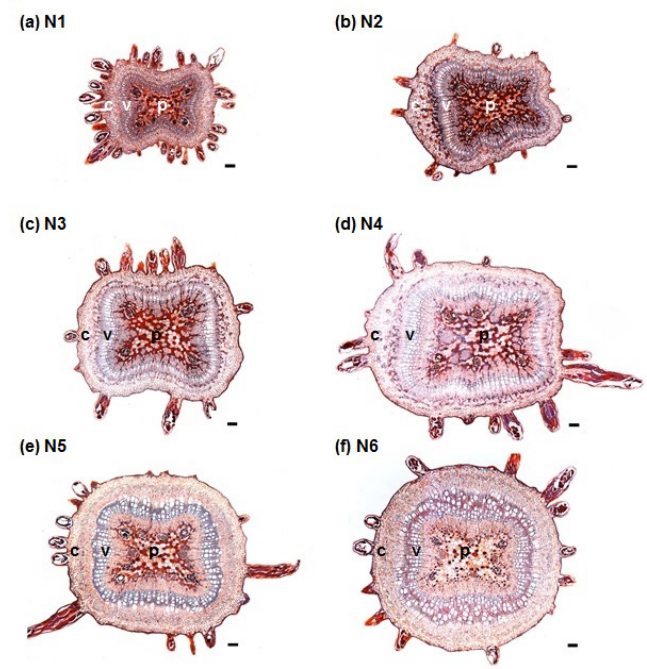
Figure 1. Transverse sections from the stem of cuttings from near node 1 (“N1”: the apical cutting) to node 6 (“N6”: the most basal cutting) of Corymbia citriodora stock plants ( a – f) . c = cortex; v = vascular tissue; p = pith. Scale bars = 100 μm.